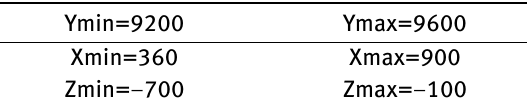
Table 2: Ranges of scope for block